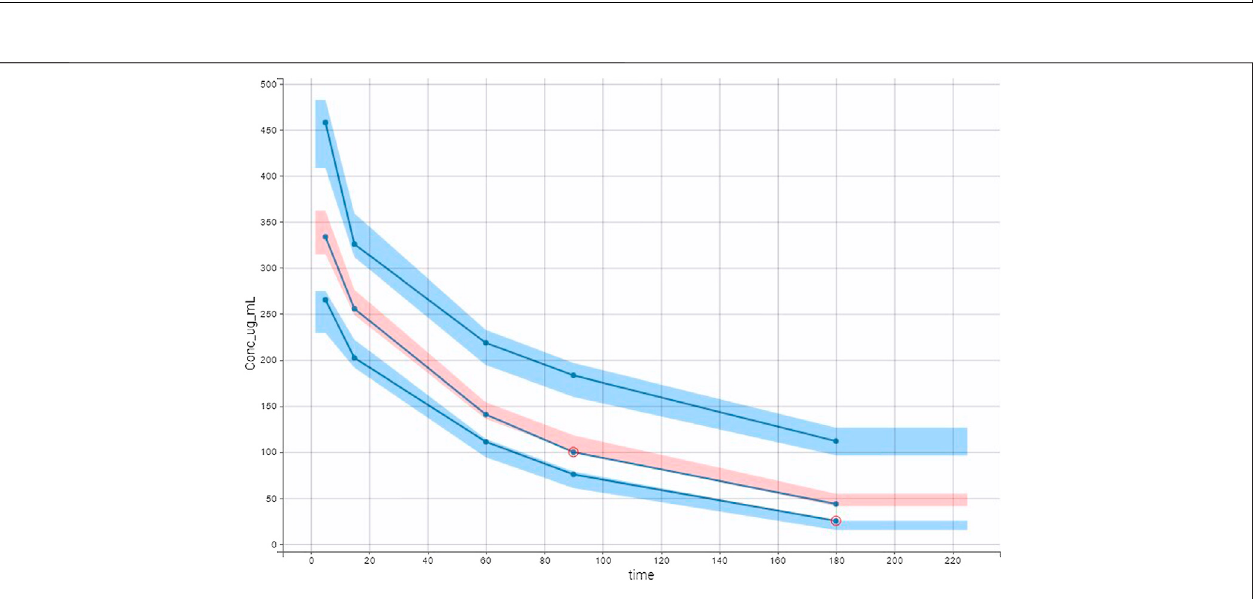
x -axis, the means of the two methods are represented (i.e., reference method by Pocar et al., 2019 and our method based on EBE). On the y -axis, the differences between the two methods are shown. The red line depends on the standard error and represents imprecision. The light blue line represents the mean and therefore the bias. The fi gure shows that the performances of the GFR estimation